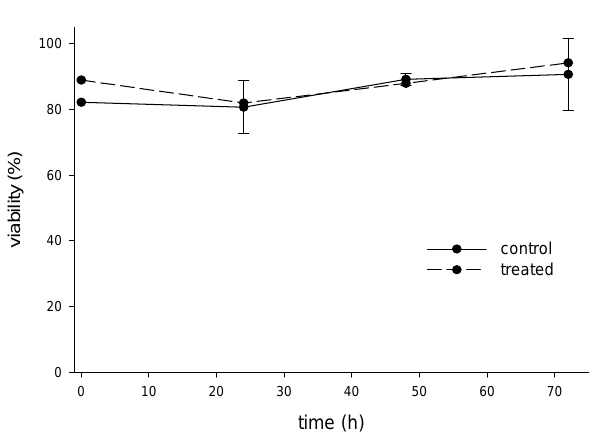
Figure 4: Resistance of A. lumbricoides ova to lime stabilization. Shown are mean and standard deviation from two replicate experiments conducted in limed water at 28°C. Continuous line show untreated control, dashed line